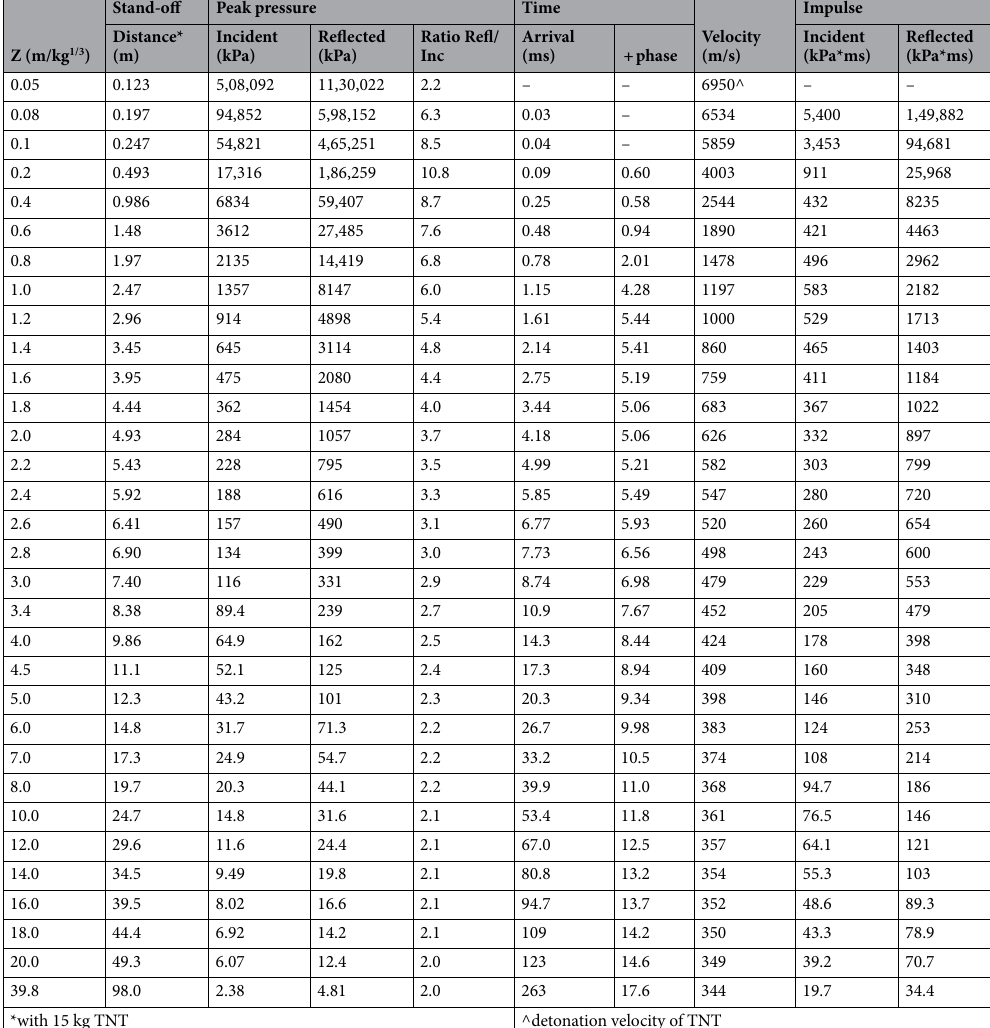
Table 1. Shock wave characteristics with stand-off distance from empirical relationships of hemispherical blasts (from Kingery 8 , Kingery, Bulmash 12 and Swisdak 17